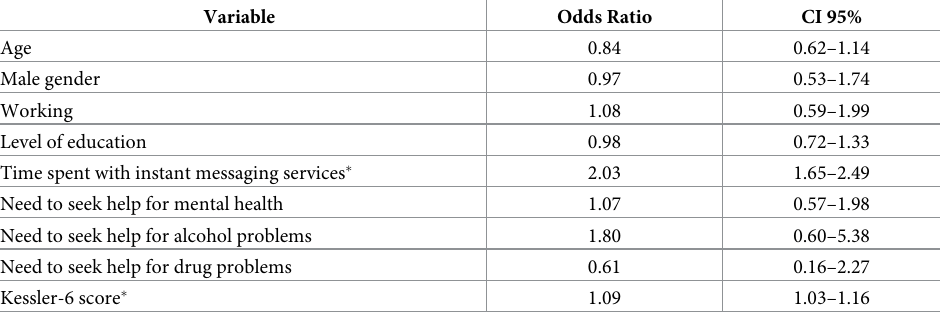
Table 4. Logistic regression analysis, analyzing correlated of problematic social media use. Age groups 39 years and younger (N = 677). Analyses after exclusion of 59 individuals with incomplete data for included variables.